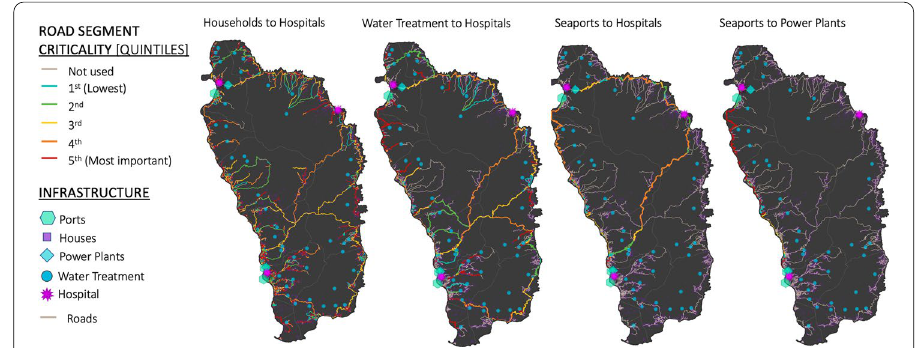
Fig. 1 Road segment criticality shown in quintiles. Criticality is calculated using drop-link analysis. More critical segments indicate that the loss of this segment increases overall travel cost for the origin–destination pair in each perspective